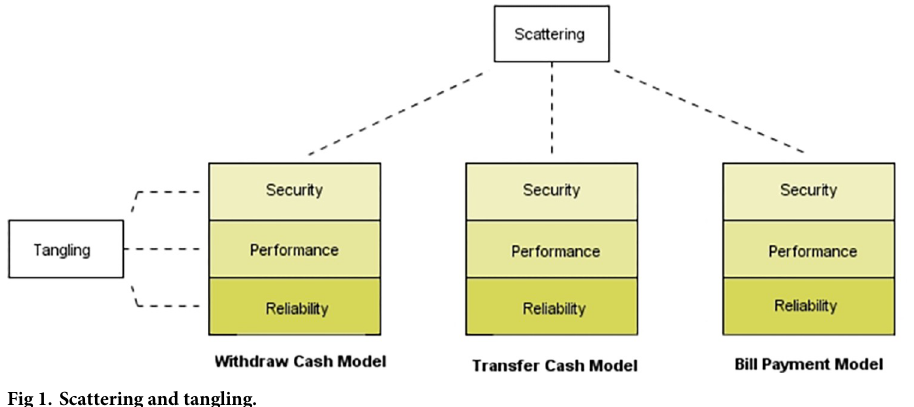
Fig 1. Scattering and